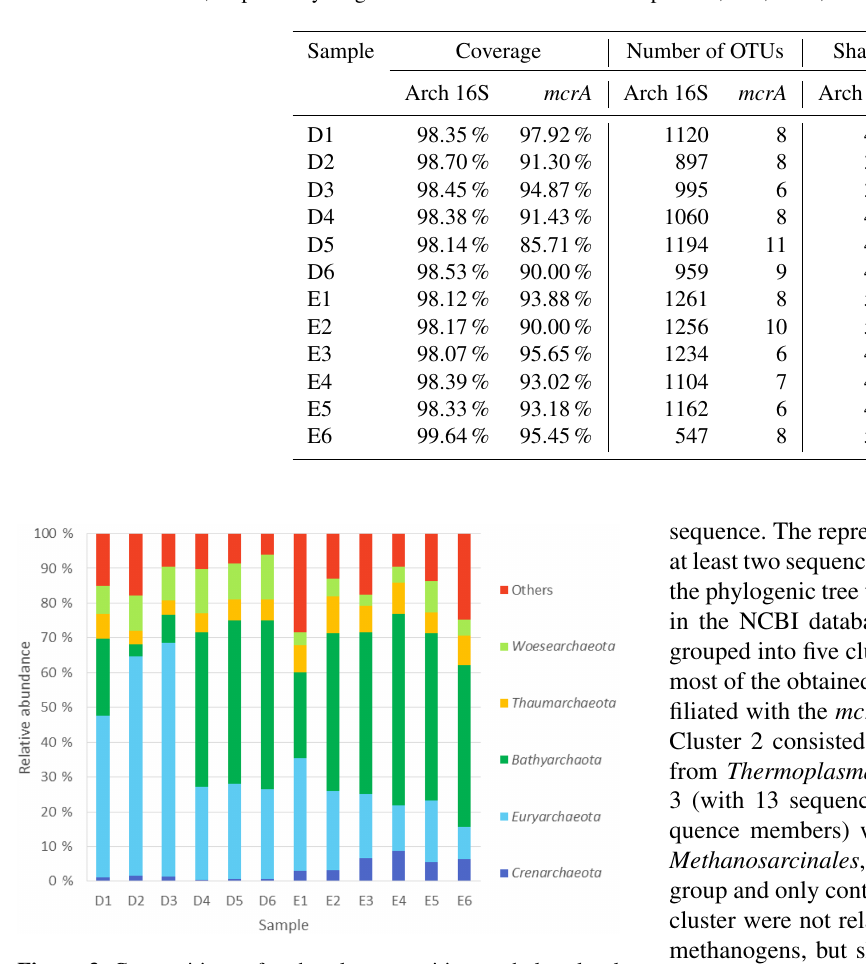
Figure 3. Compositions of archaeal communities at phylum level based on 16S rRNA gene. Samples D1–D6 and E1–E6 were re- trieved from Dianchi Lake and Erhai Lake, respectively. Digits “1”– “6” refer to sediment depth 0–5, 5–8, 8–11, 11–14, 14–17, and 17– 20cm,